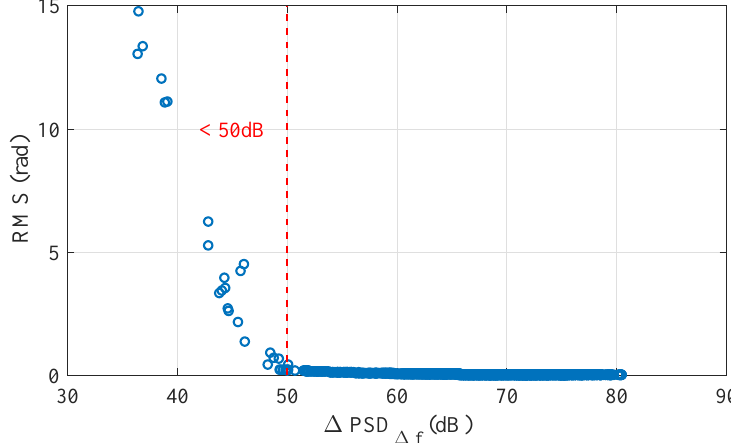
Figure 8. The RMS of the detected phase versus the relative PSD at heterodyne